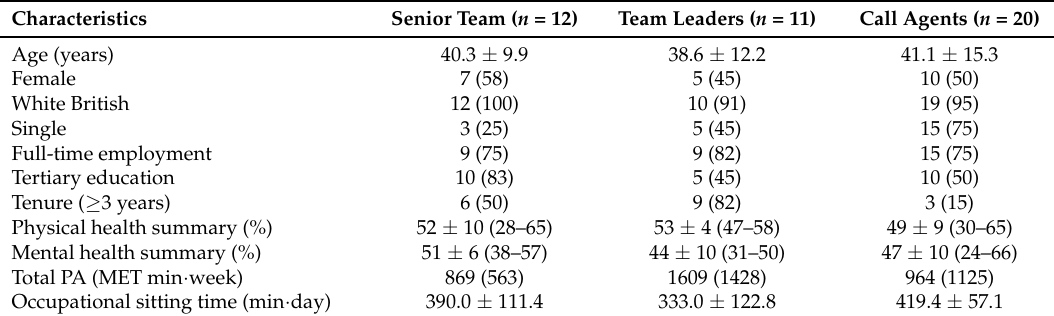
Table 1. Descriptive characteristics of contact centre employees by job